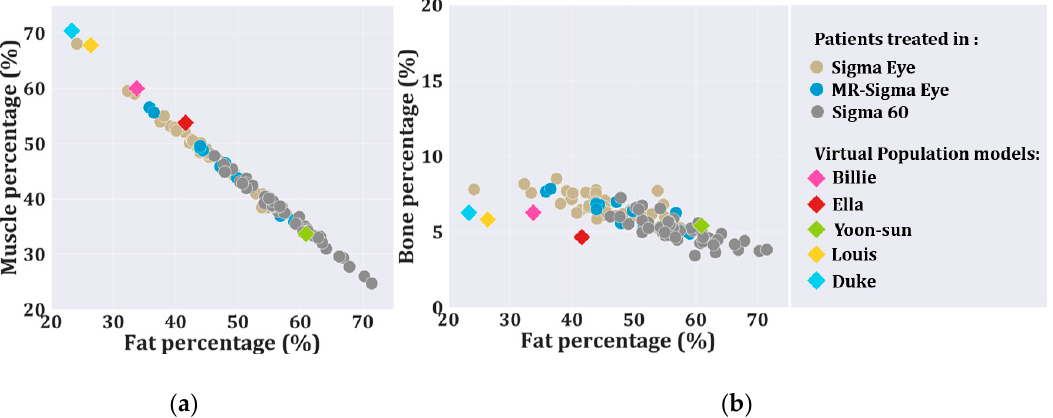
Figure 4. Scatter plots of muscle and bone volume percentage as a function of fat volume percentage, in patients treated and the virtual population models. ( a ) presents the fat and muscle percentage of the treated patients in deep-hyperthermia applicators. ( b ) presents the fat and bone percentage of the treated patients in the hyperthermia applicators mentioned. The fat, muscle, and bone percentage of the virtual models are placed with larger marker size.